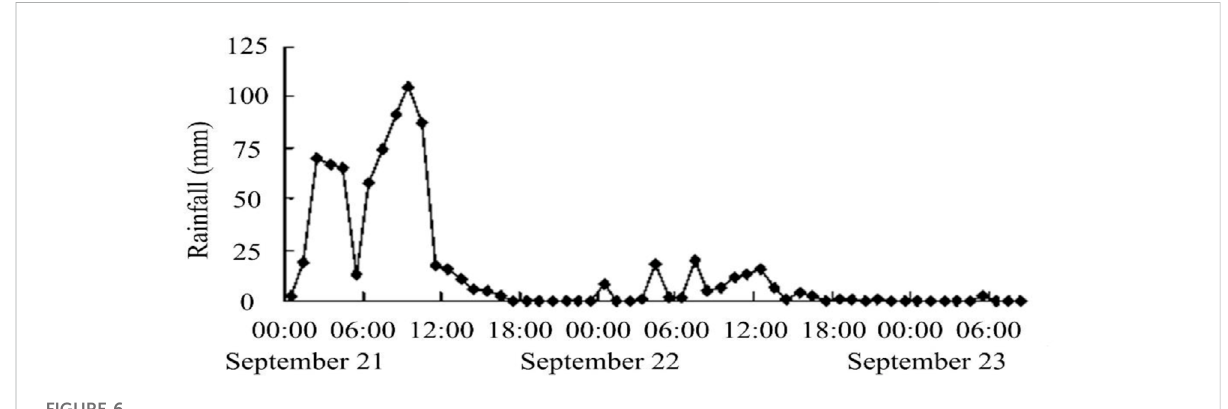
FIGURE 6 Precipitation levels associated with the landslide event of 21 September 2010.